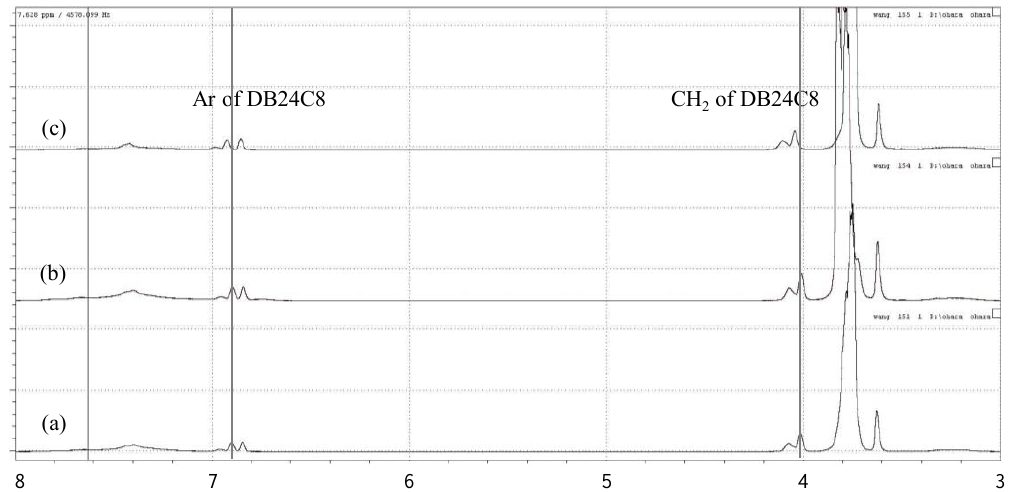
Figure 3. 1 H NMR spectra of P7 in the presence of alkali metal salt: ( a ) None; ( b ) LiCl; ( c ) CsCl.